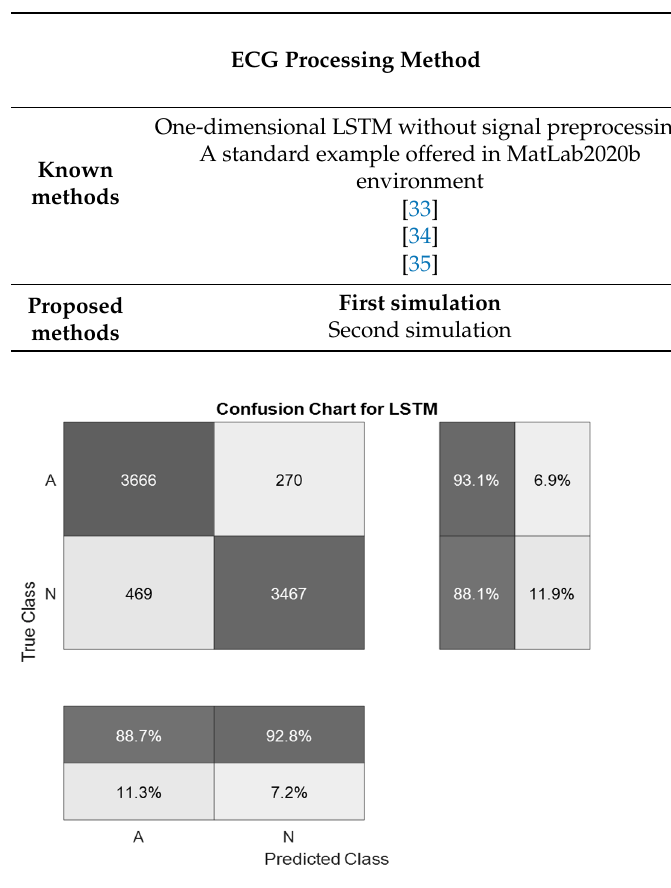
Table 3. Simulation results of various methods for detecting atrial fibrillation.